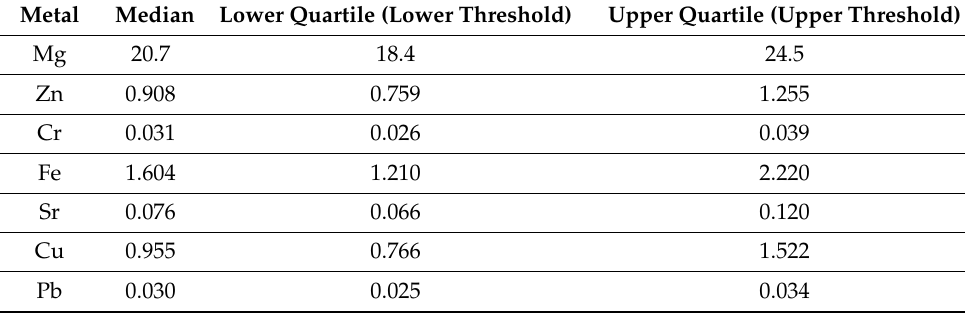
Table 2. Variational indicators of metal content in blood serum ( µ g/mL).